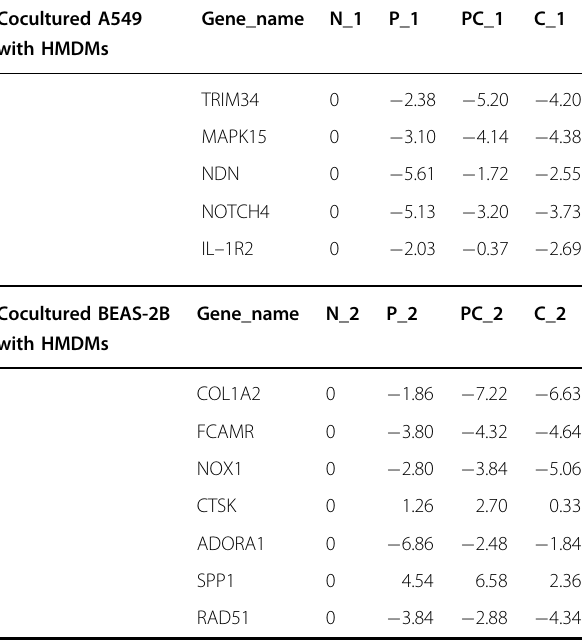
Table 2 The fold change for highlighted DEGs in the co- cultured respiratory epithelial cells with